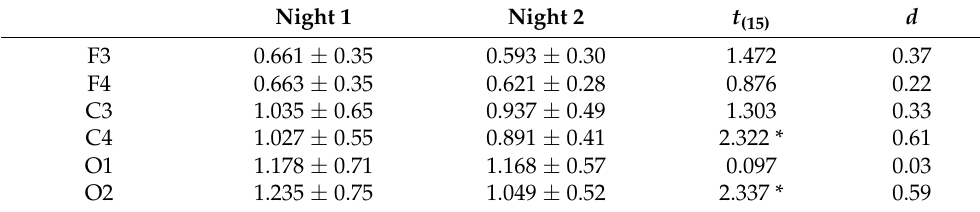
Table 3. The EEG activation index results for stage N2 on Night 1 and Night 2.